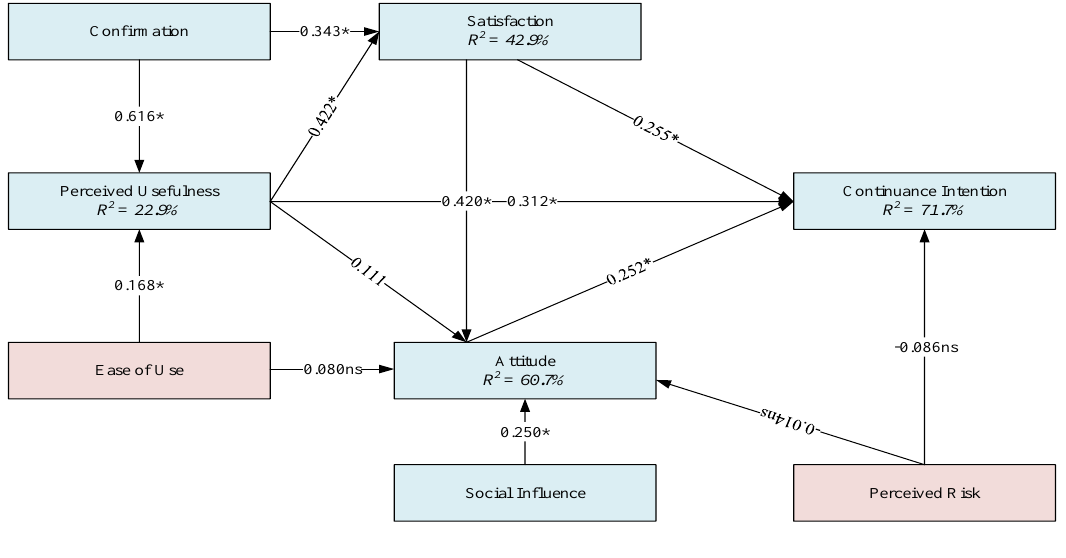
Figure 2: PLS results of the structural